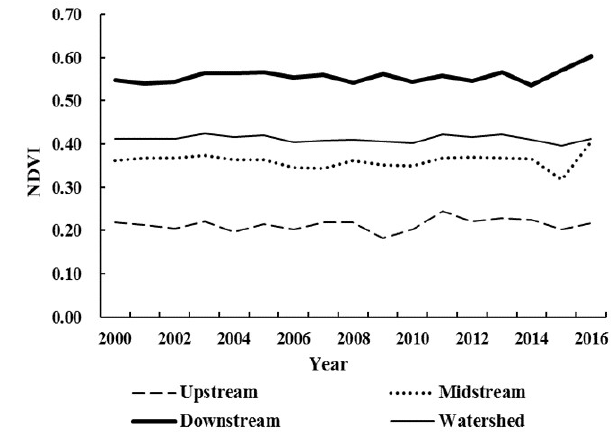
Figure 8. Distribution of NDVI in sub-basins of the Yarlung Zangbo River Basin. Table 2. Correlation analysis of NDVI and meteorological factors in the Yarlung Zangbo River